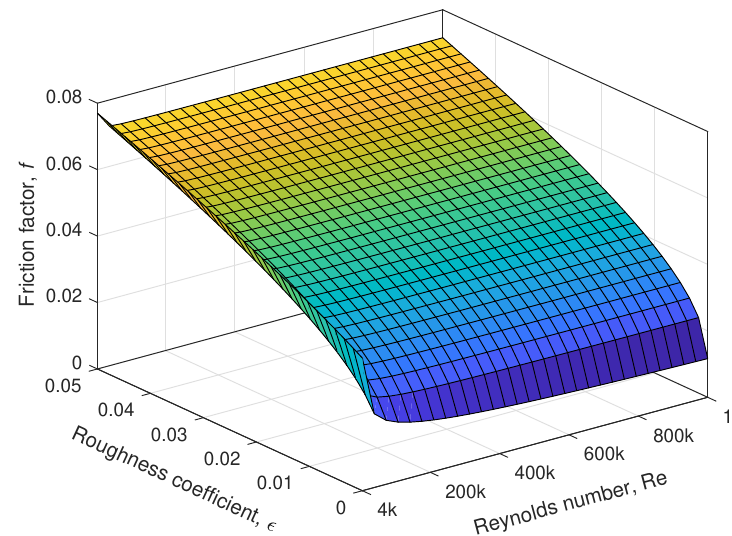
Figure 1. Variation of friction factor with roughness and Reynolds number in turbulent